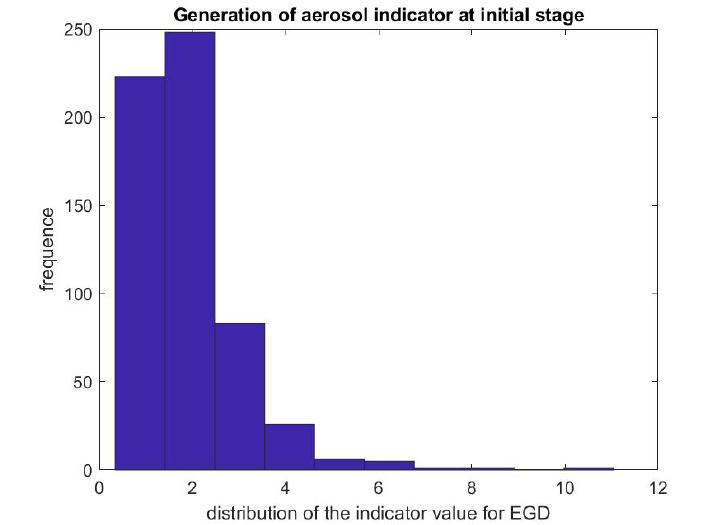
Figure 7. Particle count during the first 3 min of an EGD D egd prior to the procedure D egd pre .